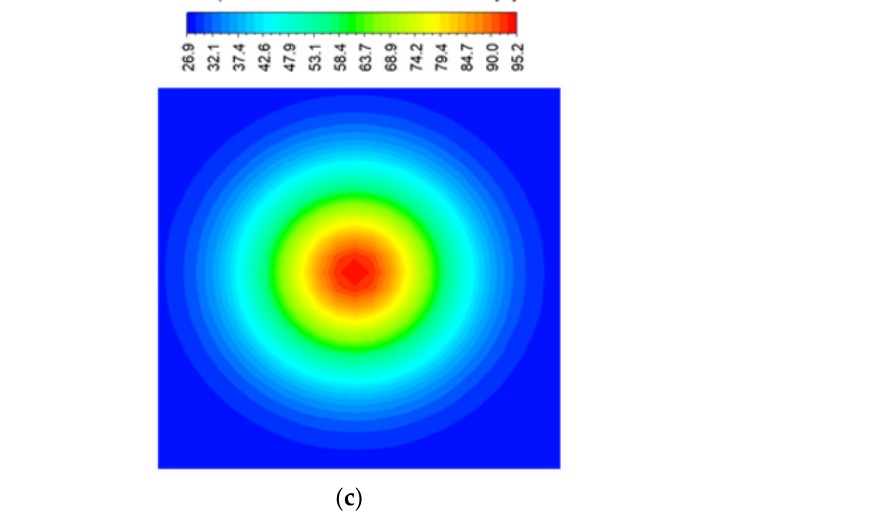
Figure 9 . Comparison of the experimental data with the numerical model: ( a ) two adjacent melting paths width measured using SEM, ( b ) two adjacent melting path widths measured numerically, ( c ) temperature contour obtained using the numerical model [12].